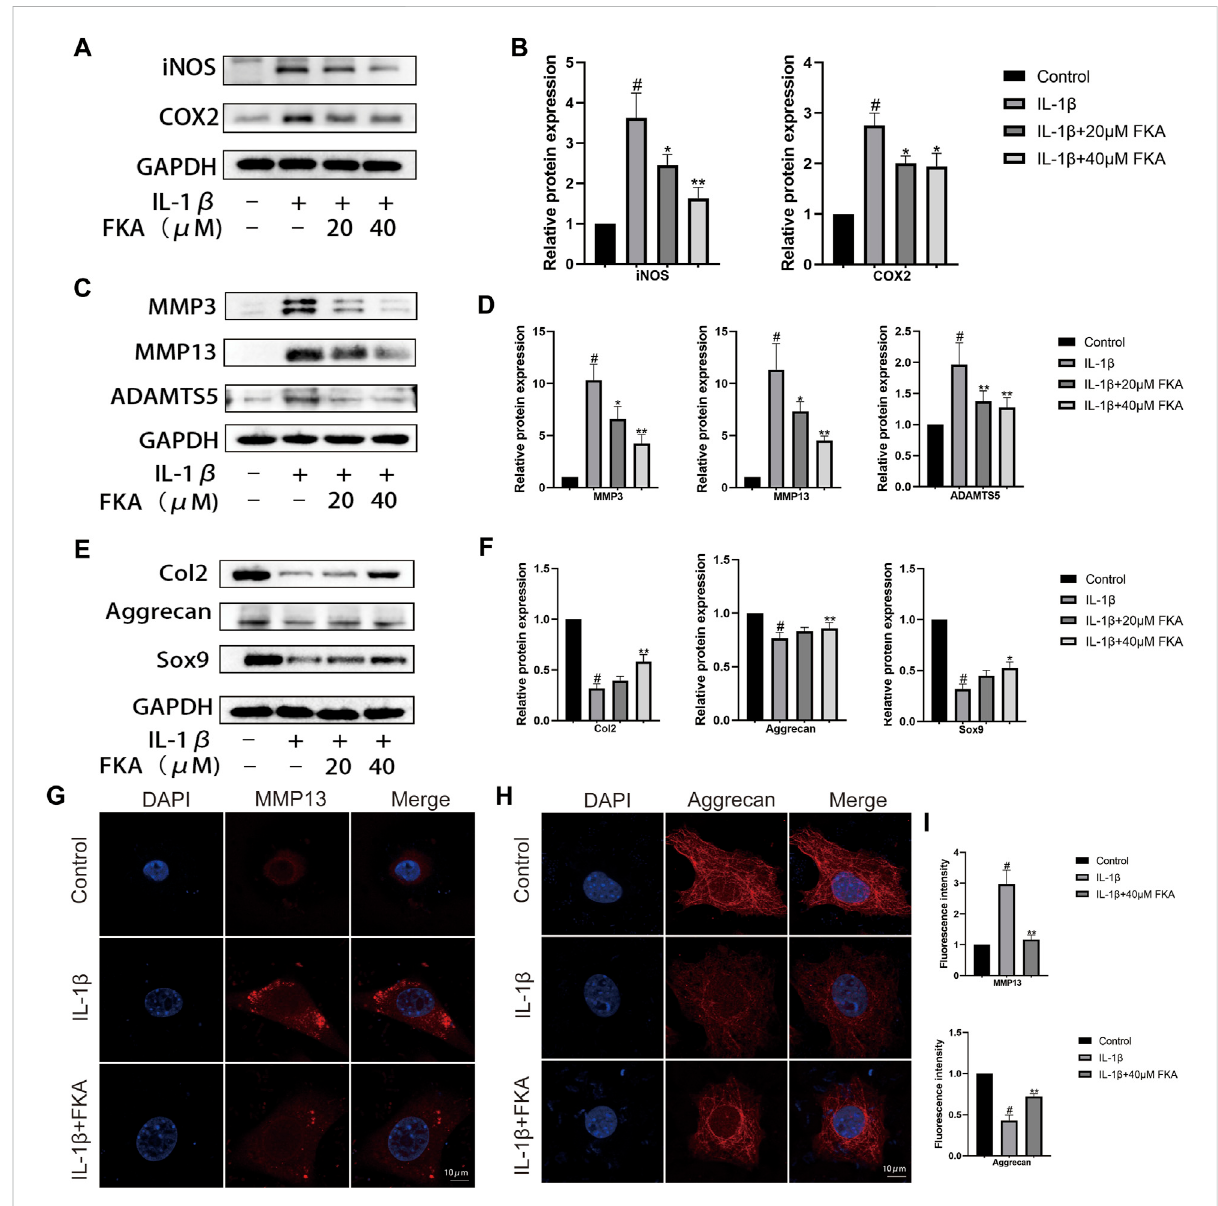
FIGURE 2 Protective effects of FKA against IL-1 β -induced in fl ammation and ECM destruction in mouse chondrocytes. Chondrocyte cell treatment with 5 ng/ml of IL-1 β only or with FKA (20 and 40 μ M) for a period of 24 h. Western blot analysis of in fl ammatory cytokines (COX2 and iNOS), catabolic (ADAMTS5,MMP3,andMMP13),andanabolicmarkers(Col2,Aggrecan,andSox9) (A,CandE) .Quantitativeanalysisofproteinexpression (B,DandF) . (GandH) 5 ng/mlofIL-1 β wasaddedfortreatingthecellsfor24 hintheabsenceorpresenceof40